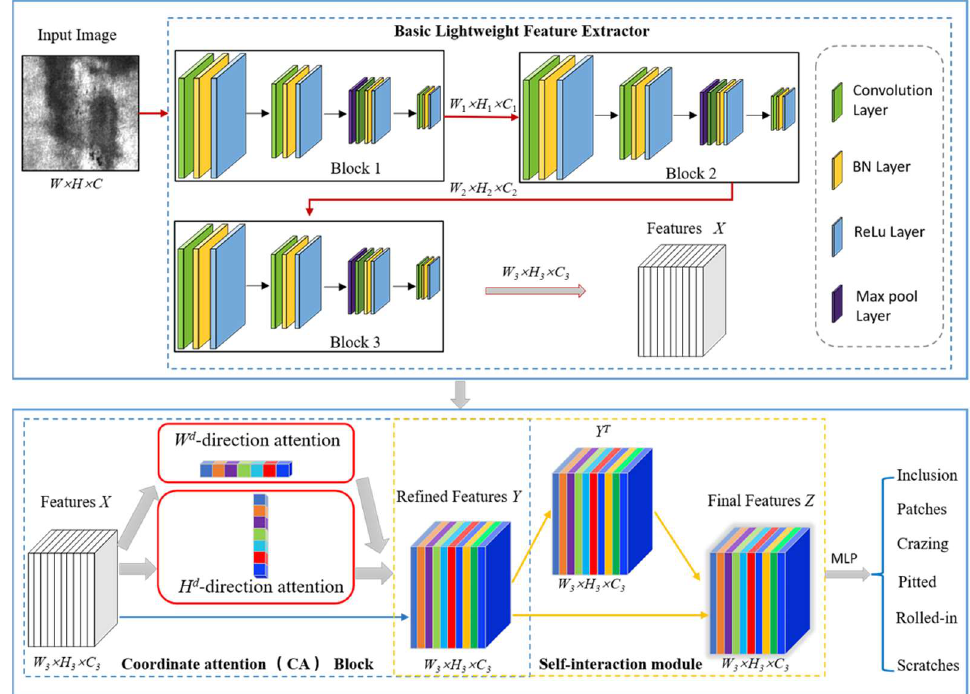
Figure 1. Overview of the CASI-Net framework.